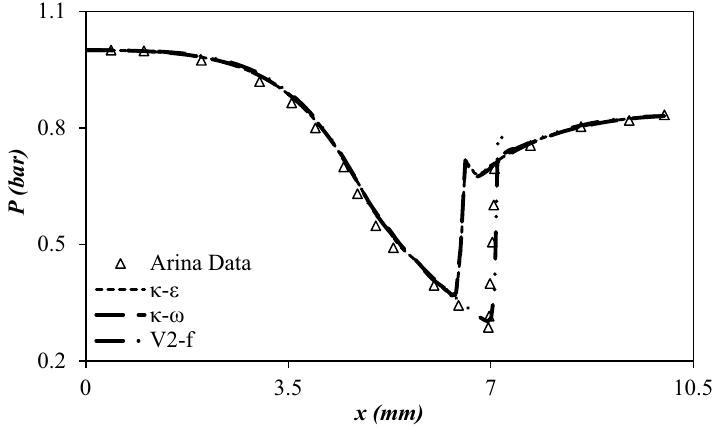
Figure 2. Comparison of predicted profile of various turbulence models with Arina’s data 56